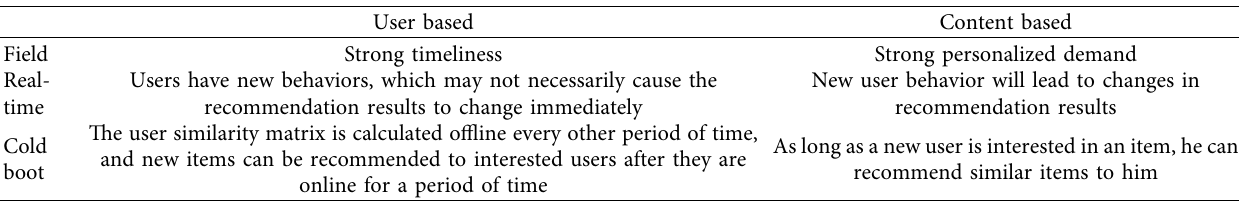
Table 4: Comparative analysis of algorithms.